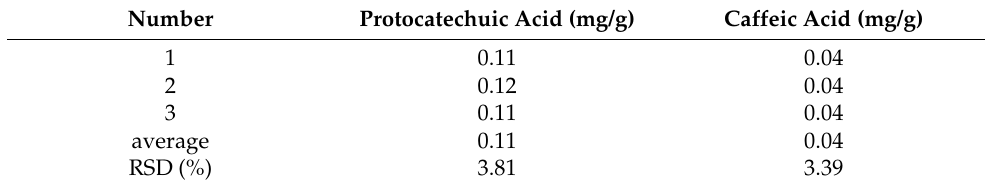
Table 4. Determination of protocatechuic acid and caffeic acid with LVSS-MEKC in Cibotium barometz